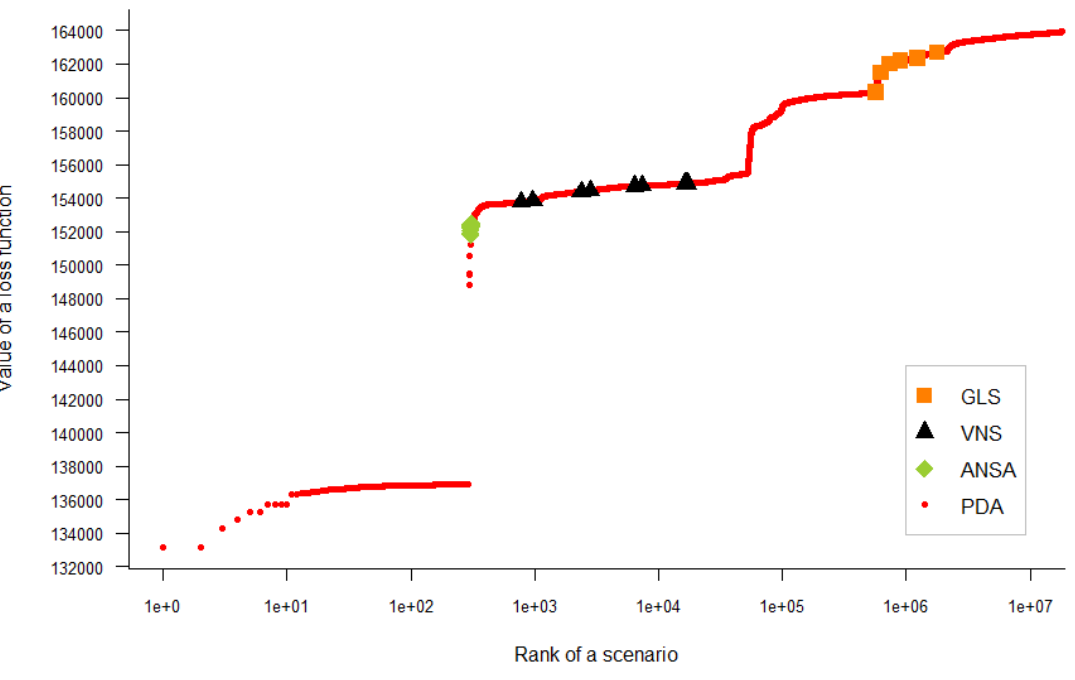
Ranks of heuristics within PDA and values of the loss function for disintegrations with four concurrently interrupted links in the Karlovy Vary region network. All 18,135,132 PDA results are drawn in the graph, due to the logarithmic